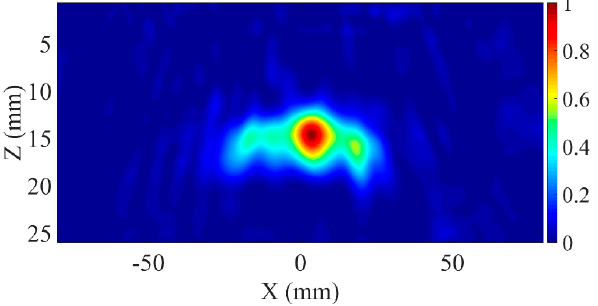
Figure 12. Reconstructed mm-wave image for Test 6 .